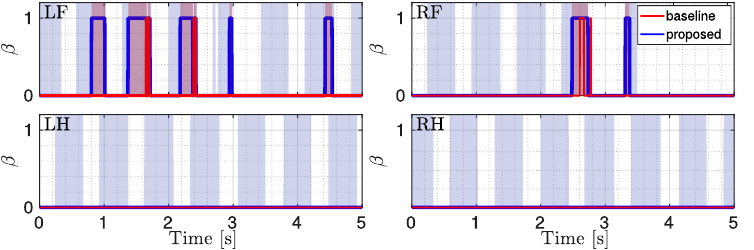
Figure 10. Comparison between the flags. The red one is obtained with the baseline approach, the blue one with the proposed approach. The gray shaded area shows stance phases and the red shaded area indicate the ground